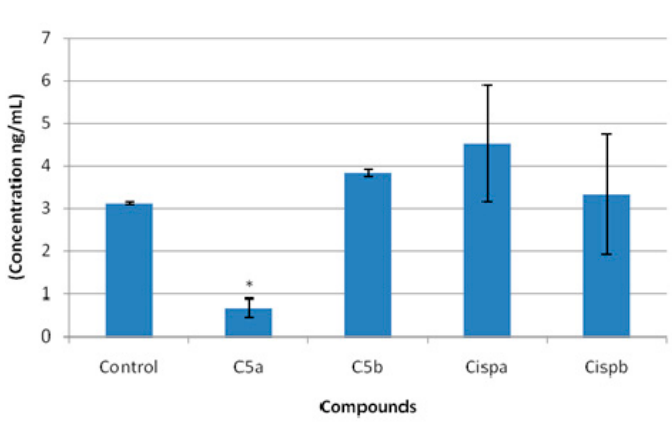
Figure 6. The effects of compound 5 on SIRT1 levels in C6 rat glioma cell line. a: IC 50/2 concentration; b: IC 50 concentration; * significance from control group p < 0.05. Table 5. The effects of compound 5 on SIRT1 Activity.